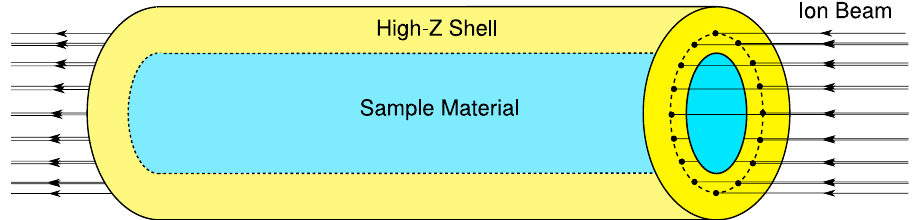
Figure 3. Beam–target set up of the LAPLAS scheme using an annular focal